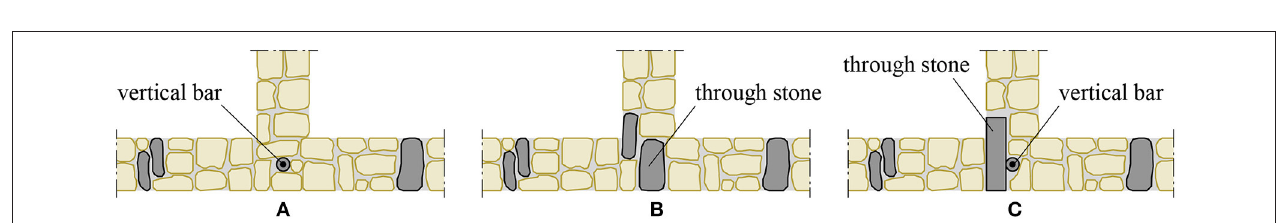
FIGURE 9 | Principles of masonry details with (A) vertical steel bar in T-section and (B) through stone in T-section (both following Arya et al., 2014). (C) vertical steel bar and through stone in T-section (following BMTPC, 2000; all by courtesy of Smart Shelter Foundation).